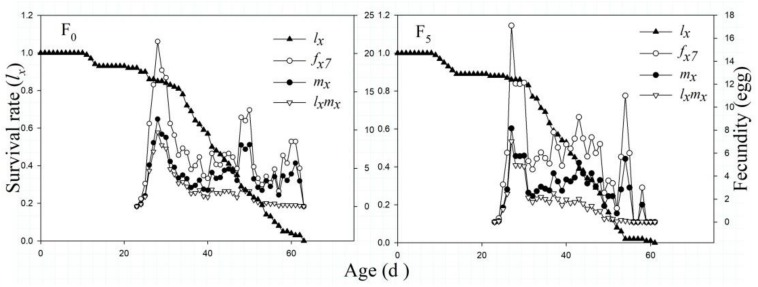
The age-specific survival rate (lx), female age-specific fecundity (fx7), age-specific fecundity of the total population (mx), and age-specific net maternity (lxmx) of the F0 and F5 generations of L. striatellus.